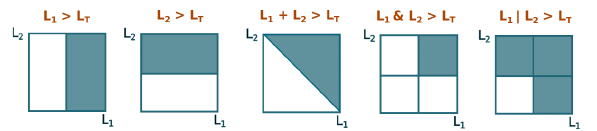
Figure 4. Loss combination strategies: Require only the loss of jet 1 or only the loss of jet 2 to be above the loss threshold L T (first and second figure), require the sum of both jet losses to exceed L T (third figure), require both losses to be above L T (fourth figure) or require that either the loss of jet 1 or the loss of jet 2 be above L T .